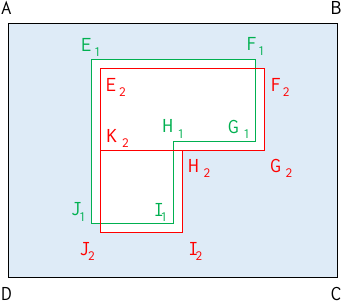
Figure 11. An example of two geometrically matched polygons (considering error tolerances) that are syntactically different.